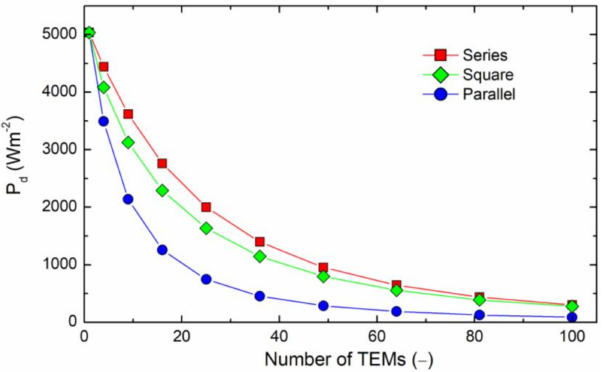
Figure 10. Power density as a function of the number of TEMs employed in an ATEG (operating point